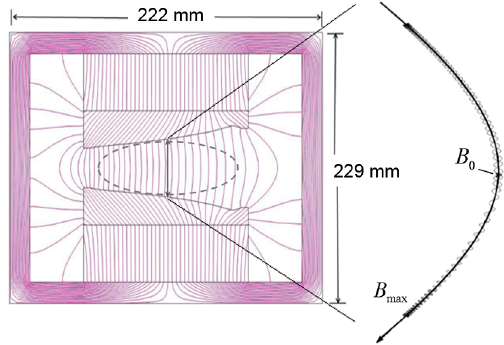
FIG. 2. Electron cloud can get trapped by a magnetic field of a combined function magnet. Image shows the field lines inside a recycler permanent combined function dipole; the gray dashed line represents the vacuum